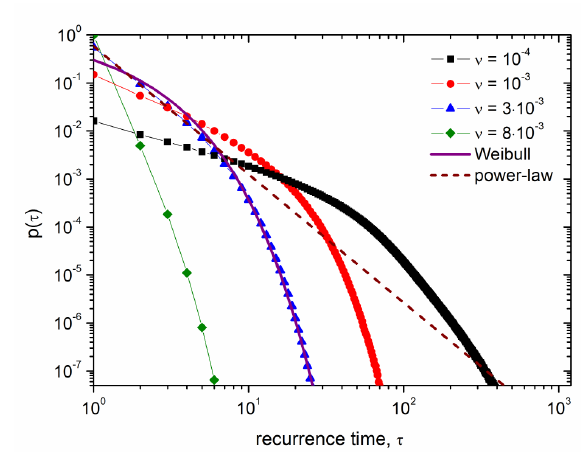
1 Fig. 3. Recurrence time distribution p(τ) for different values of the Figure 3. Recurrence time distribution p (  ) for different values of the driving rate  . In the 2 driving rate ν . In the simulations, the values of the conservation simulations, the values of the conservation parameter C and the threshold q are kept constant, ( C = 3 parameter C and the threshold q are kept constant ( C = 0.4, q = 5). 0.4, q = 5). Also shown are the power-law distribution with negative exponent  = -2.67 (short dash 4 Also shown are the power-law distribution with negative exponent α = − 2.67 (short dash line) and the Weibull distribution with 1 /β = line), and the Weibull distribution with 1/  = 1.15 and shape parameter  = 0.82 (solid line). 5 1.15 and shape parameter γ = 0.82 (solid 6